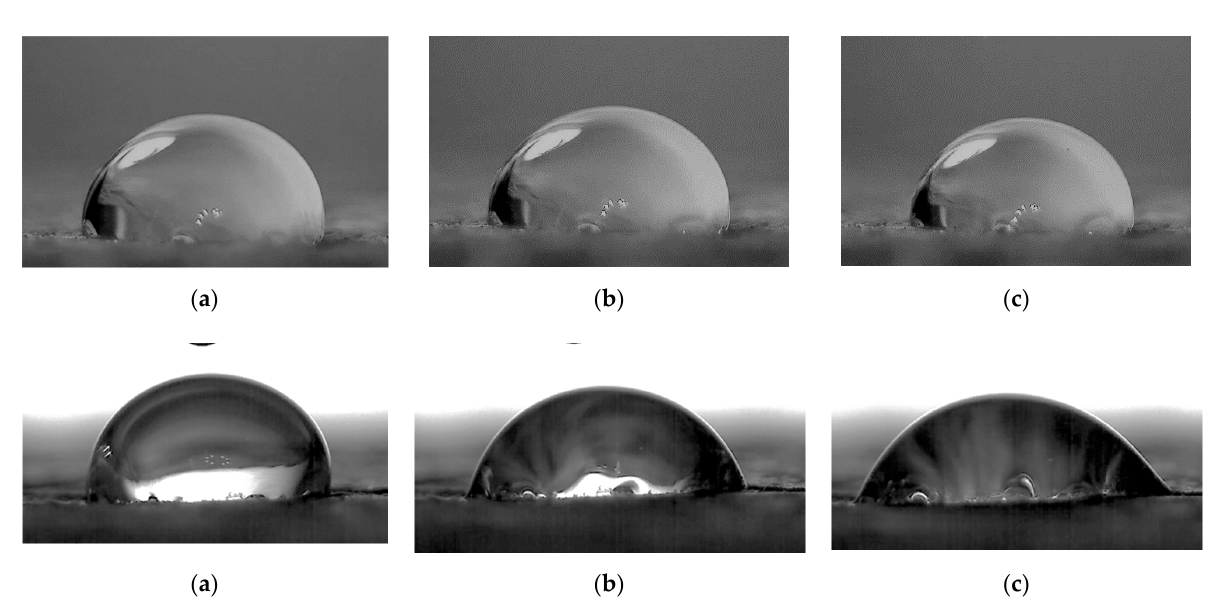
Figure 5. Representative measurement of the contact angle of a water droplet ( a ) the first time the water touches the surface of the board (t = 0 s); ( b ) as the water is absorbed (t = 60 s); ( c ) the static contact angle on fine and coarse D. asper bamboo particleboard (t = 180 s).